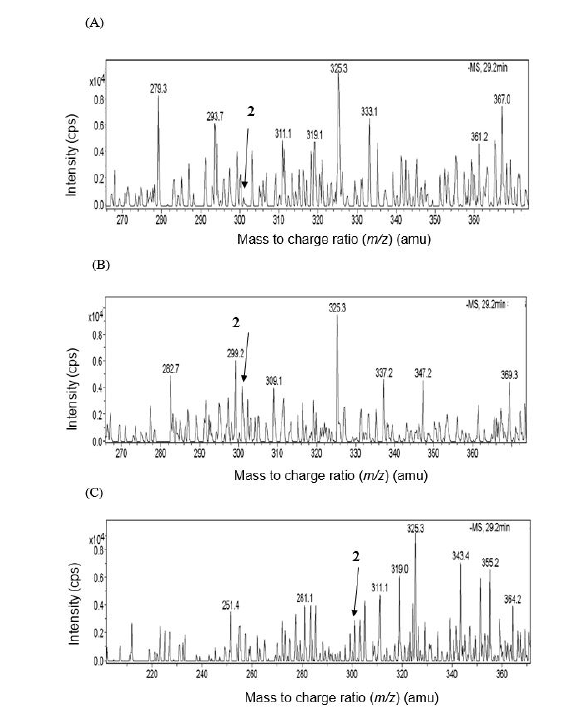
Figure 7. ESI-MS analysis of quercetin in E. sonchifolia. 2. quercetin, with m/z 301 [M-H] - , indicated above at retention time 29.2. (A) control plants, (B) heat-stressed plants, and (C) drought-stressed plants.